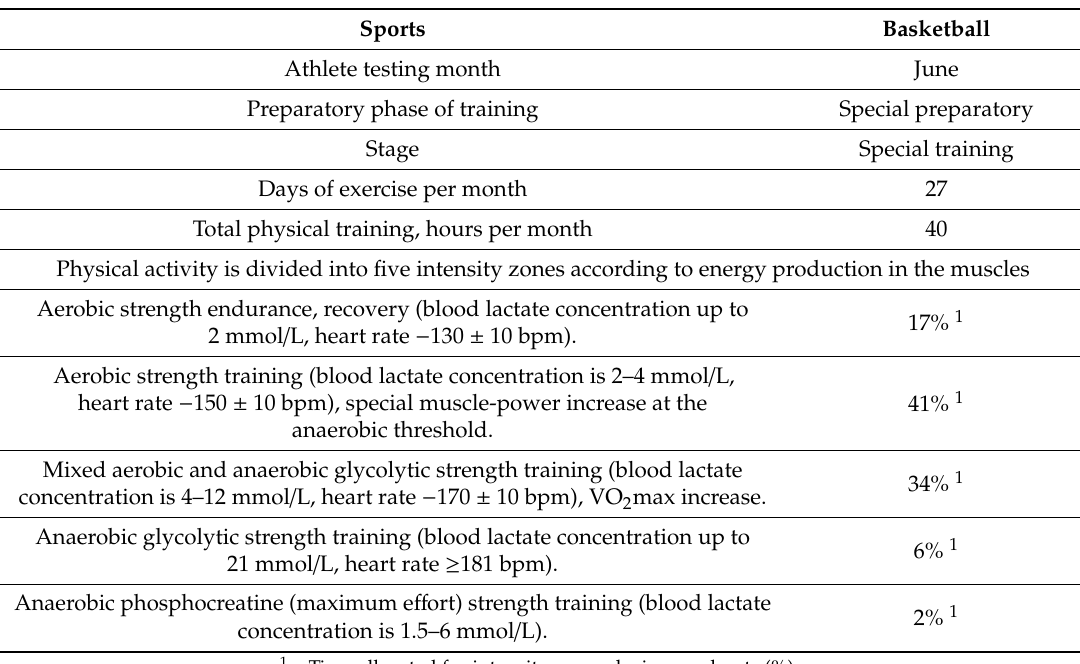
Table 1. Training plans for deaf